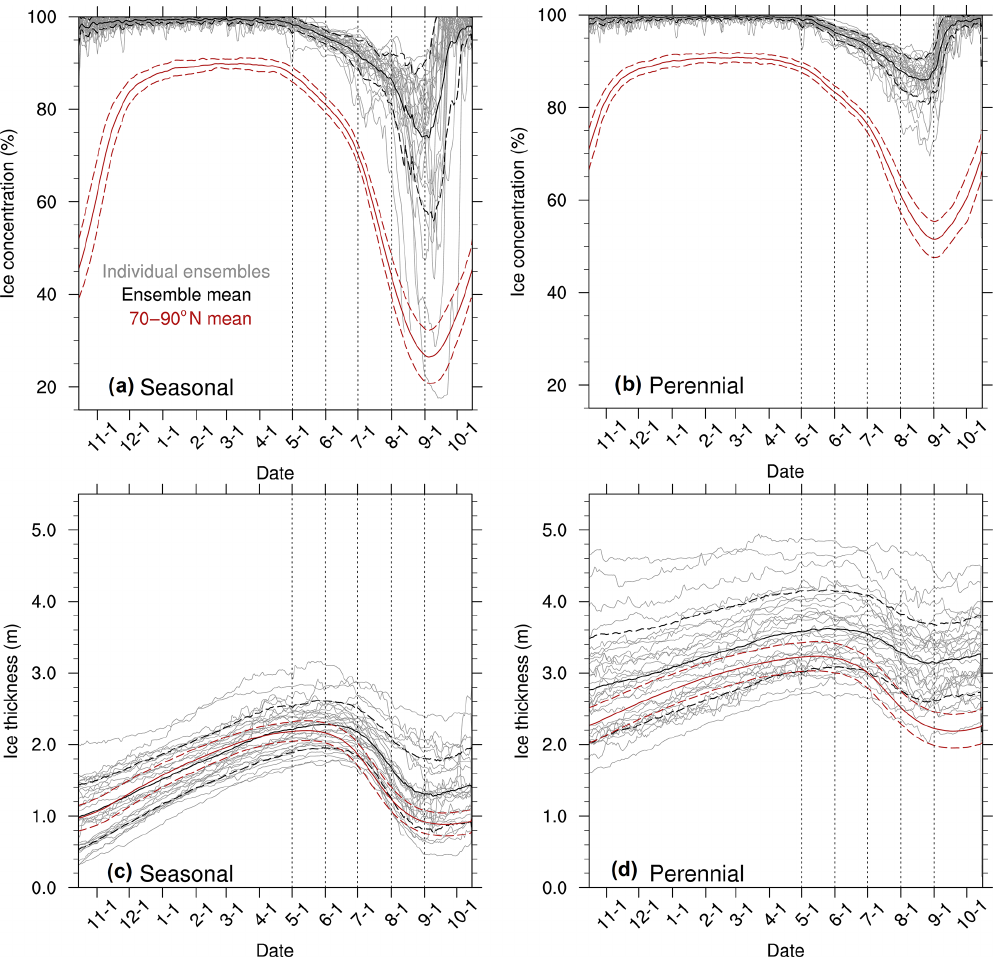
Figure 5. Year-long daily mean sea ice concentration (a, b) and sea ice thickness (c, d) for seasonal tracks (left column) and perennial (right column) tracks. Ice state for each unique ice floe tracks (grey) are overlain by the ensemble mean (solid black) and polar cap (70–90 ◦ N) daily mean ice state (solid red) and respective ± 1 standard deviation